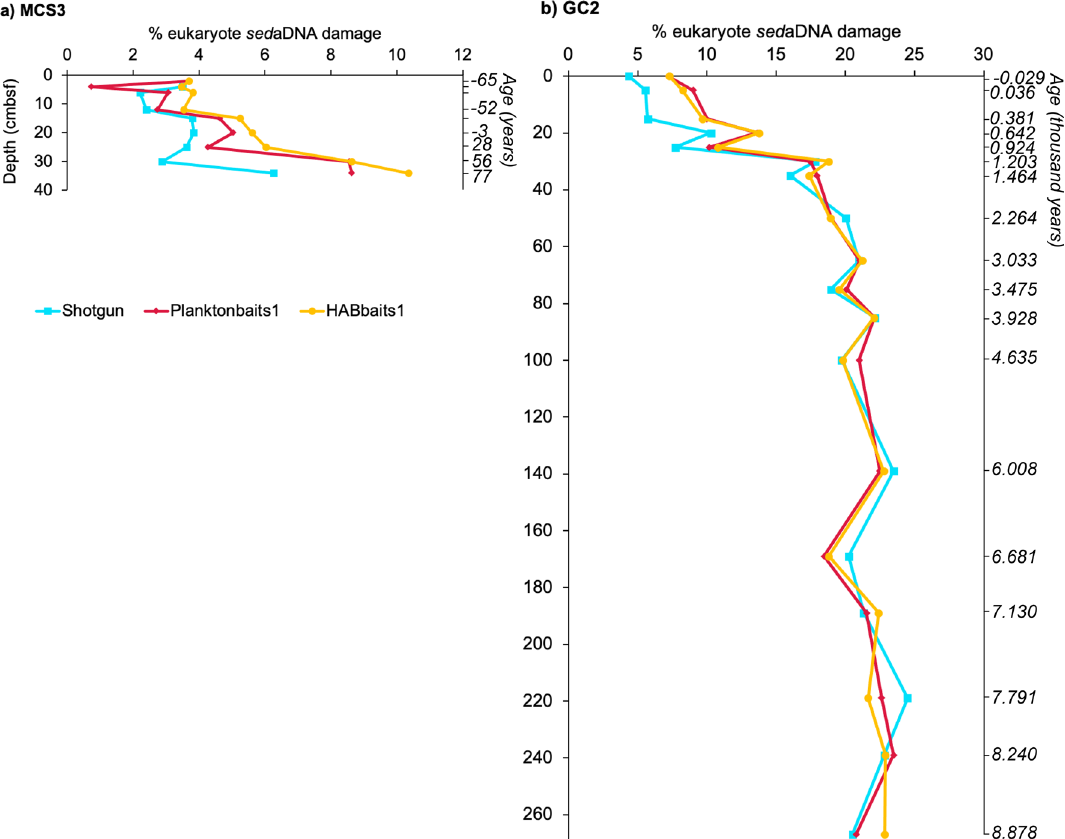
Figure 4. Eukaryote sed aDNA damage with subseafloor depth. Shown is the increase in % eukaryote sed aDNA damage with depth (centimetres below seafloor, cmbsf) in both ( a ) MCS3, ( b ) GC2. See Table 2 for correlation between % eukaryote sed aDNA damage per dataset (Shotgun, Planktonbaits1, HABbaits1) and depth, and amongst the datasets. Age of sediment cores is recorded relative to the year 1950 (reference date for radiocarbon dating), i.e. , MCS3 is ~ 145 years old ( a ) and GC2 ~ 8946 years old ( b ), and negative ages indicate years post-1950 (e.g. , an age of -65 equals the year 2015).